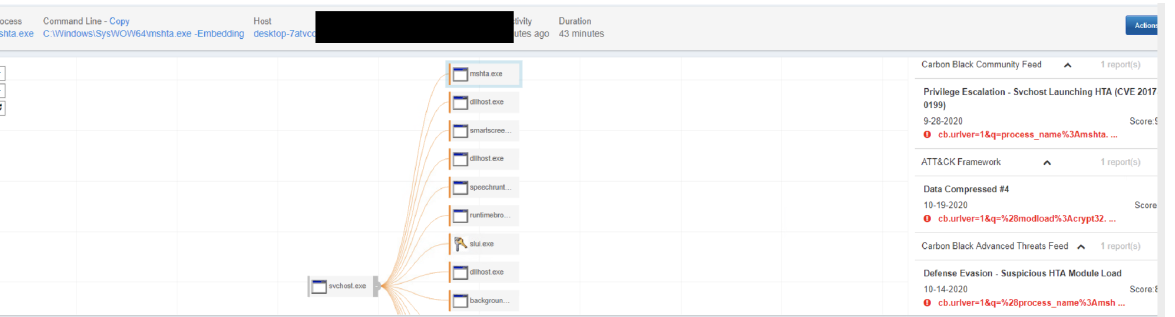
Figure 6. Carbon Black findings for